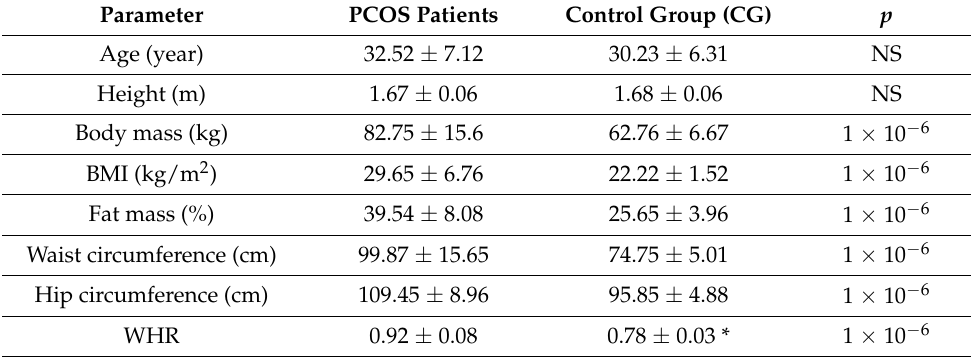
Figure 1. Study design. Table 1. The characteristics of the study group and the control group.